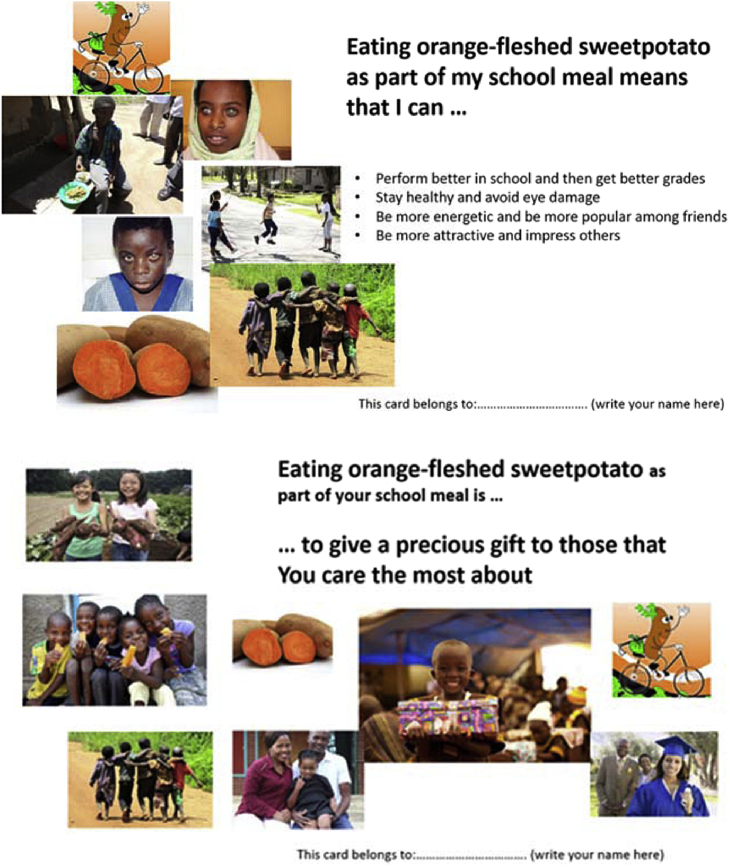
Material used for instrumental (upper panel) and experiential (lower panel) priming of orange-fleshed sweetpotato (OFSP) as part of the school meal.